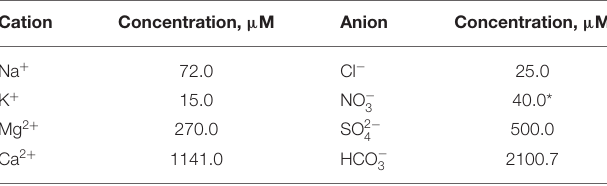
TABLE 1 | The concentrations of major cations and anions in artificial river water. Cation Concentration, µ